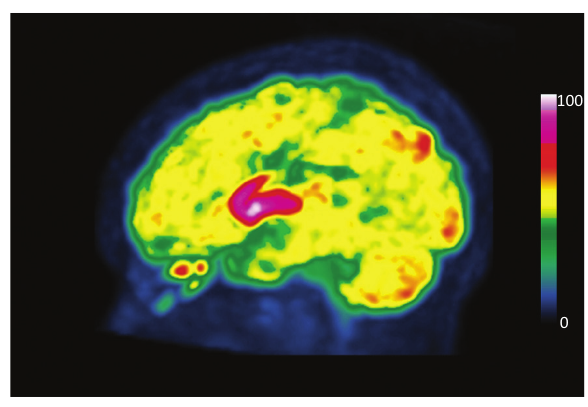
FIGURE 7: Fluorine-18 FDG PET (maximum intensity projection) in a patient known with systemic lupus erythematosus who presented with new-onset of choreoathetoid movements. Intense, symmetrical uptake in the striatal nuclei is consistent with a known neurological manifestation of systemic lupus erythematosus. MRI in this case reported non-specific features of